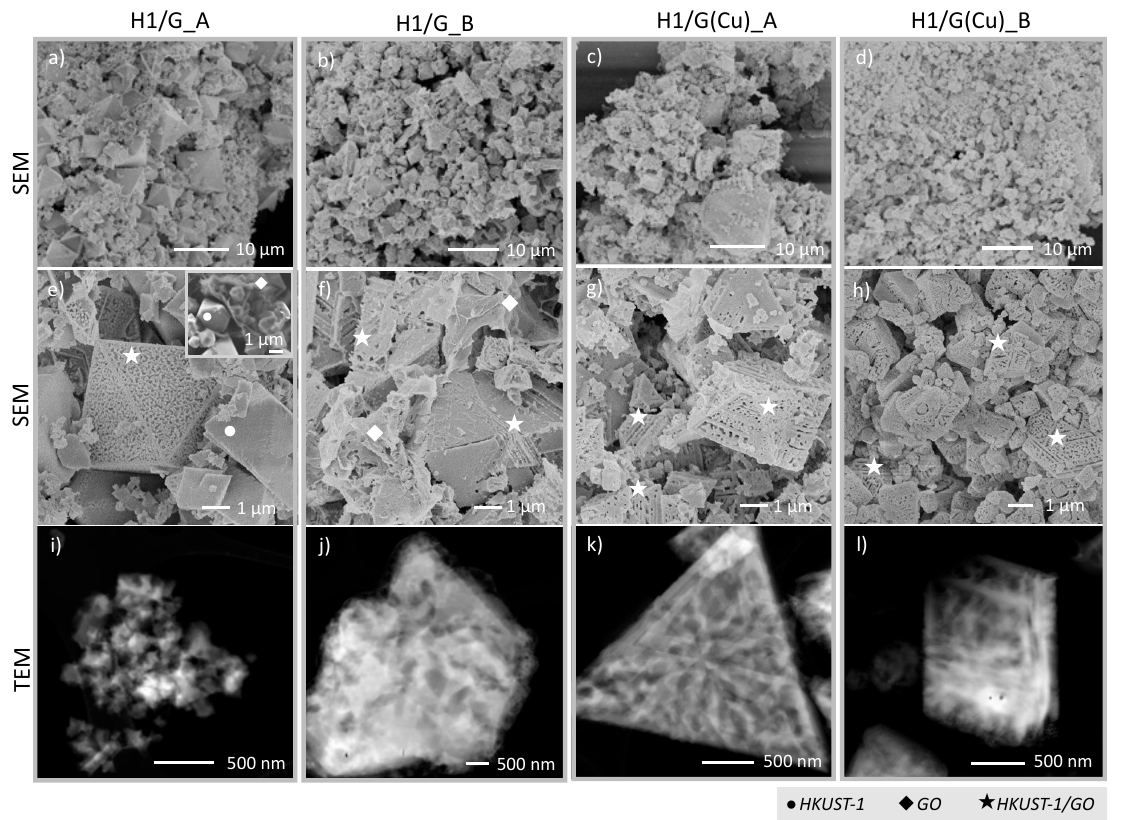
Figure 2. SEM ( a – h ) and TEM images ( i – l ) of HKUST-1/GO composites: H1/G_A ( a , e , i ), H1/G_B ( b , f , j ), H1/G(Cu)_A ( c , g , k ), and H1/G(Cu)_B ( d , h , l ).